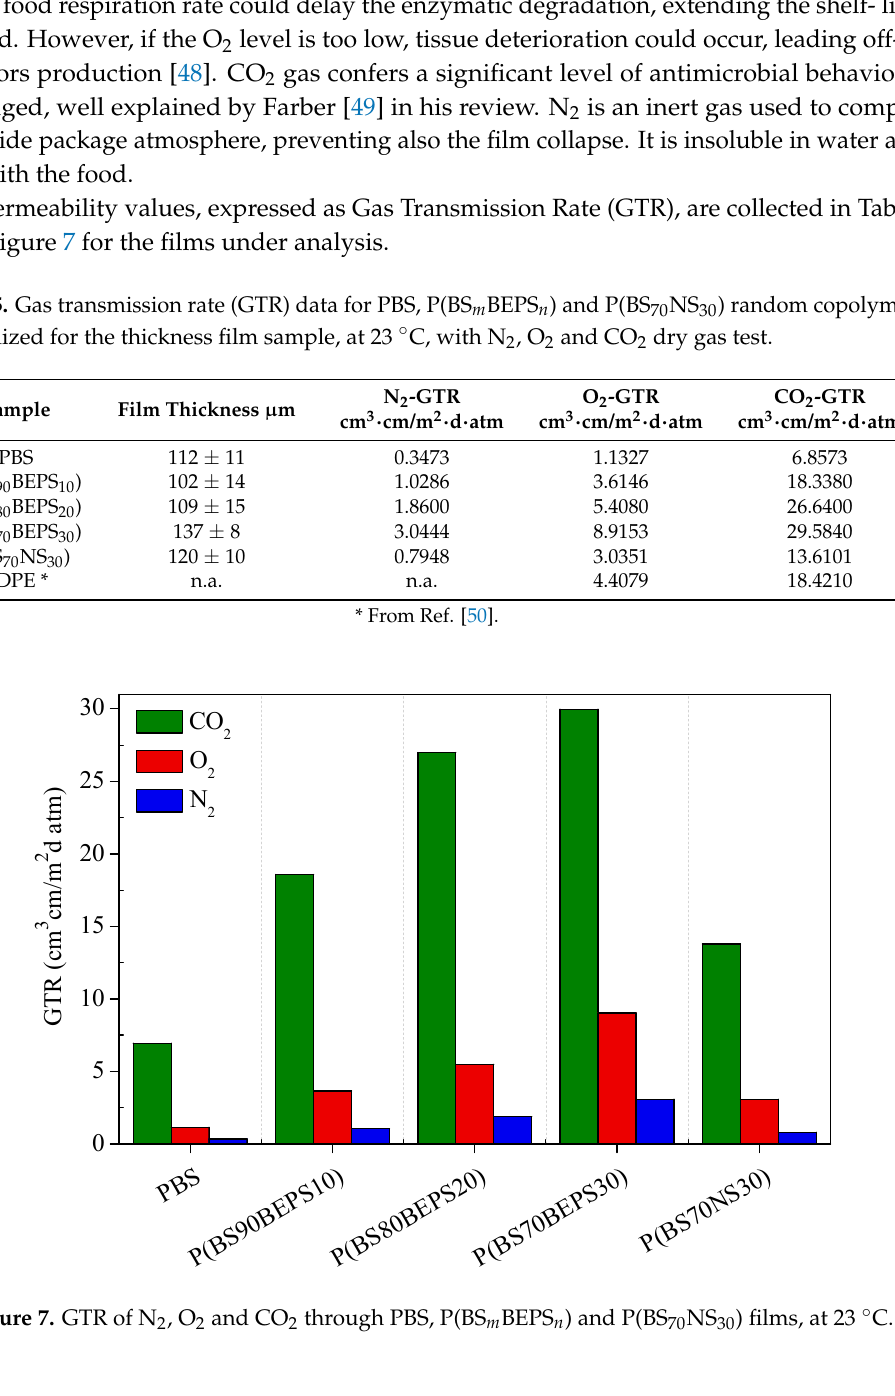
Figure 7. GTR of N 2 , O 2 and CO 2 through PBS, P(BS m BEPS n ) and P(BS 70 NS 30 ) films, at 23 °C.